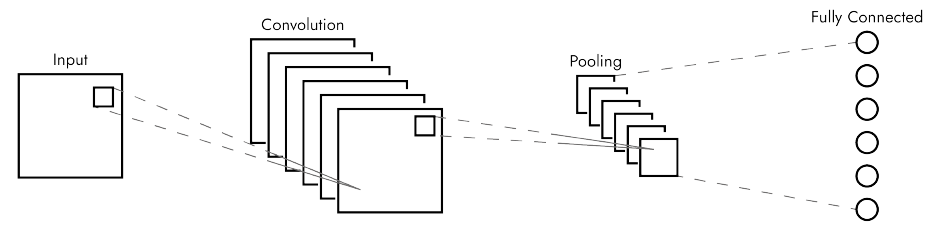
Figure 3. Convolutional neural network architecture.